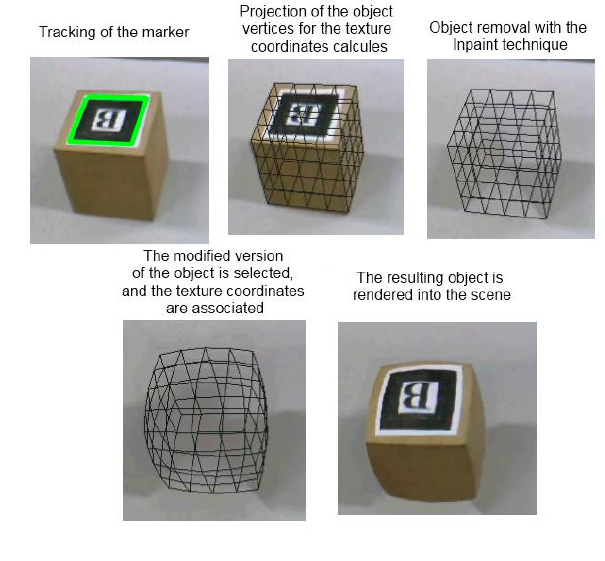
Figure 5. Overview of the steps of the technique